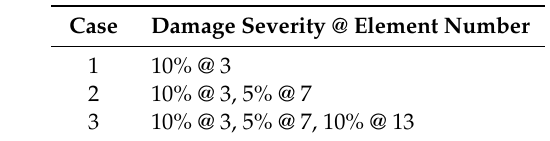
Figure 3. The simply supported beam. Table 4. Three damage cases.